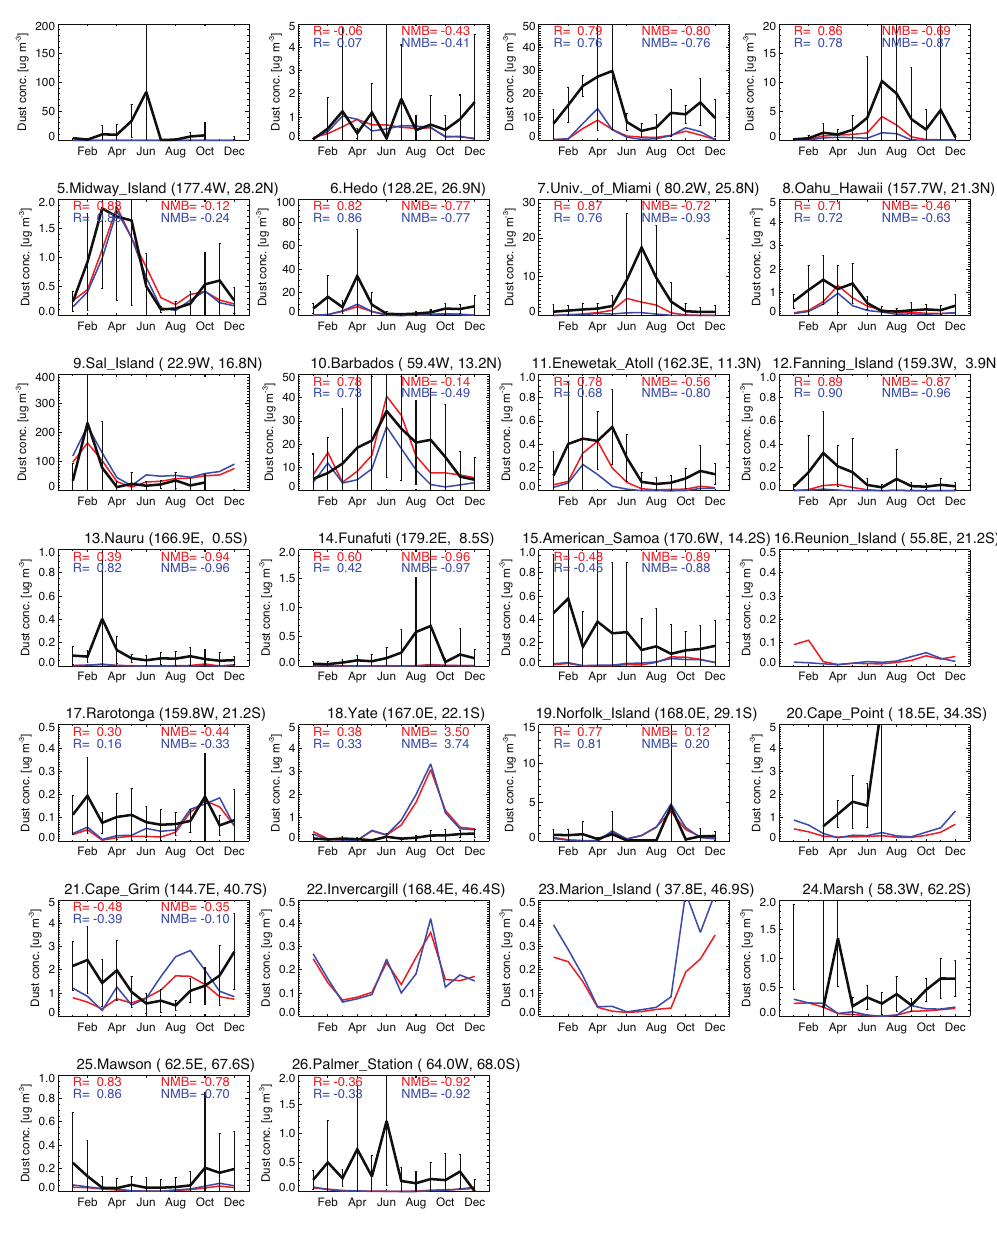
Figure 13. Same as Fig. 9 but for dust mass